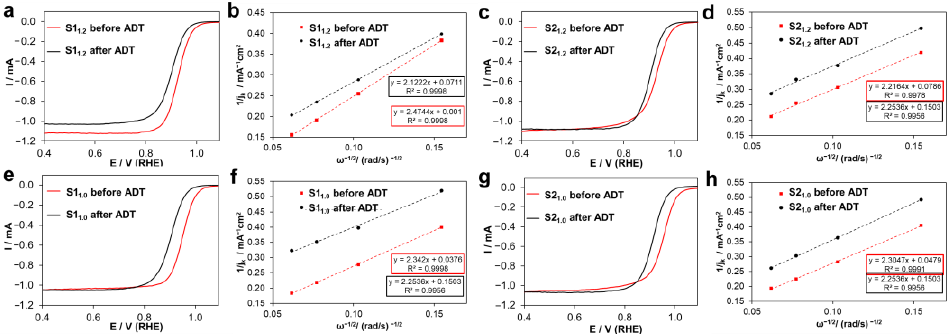
Figure 3. The ORR LSV curves of the PtCu/C catalysts before and after the ADT; the electrolyte is 0.1M HClO 4 , under an O 2 atmosphere, 20 mV/s, 1600 rpm ( a , c , e , g ); The dependence in the Koutetsky – Levich coordinates at 0.90 V ( b , d , f , h ) for the corresponding materials.